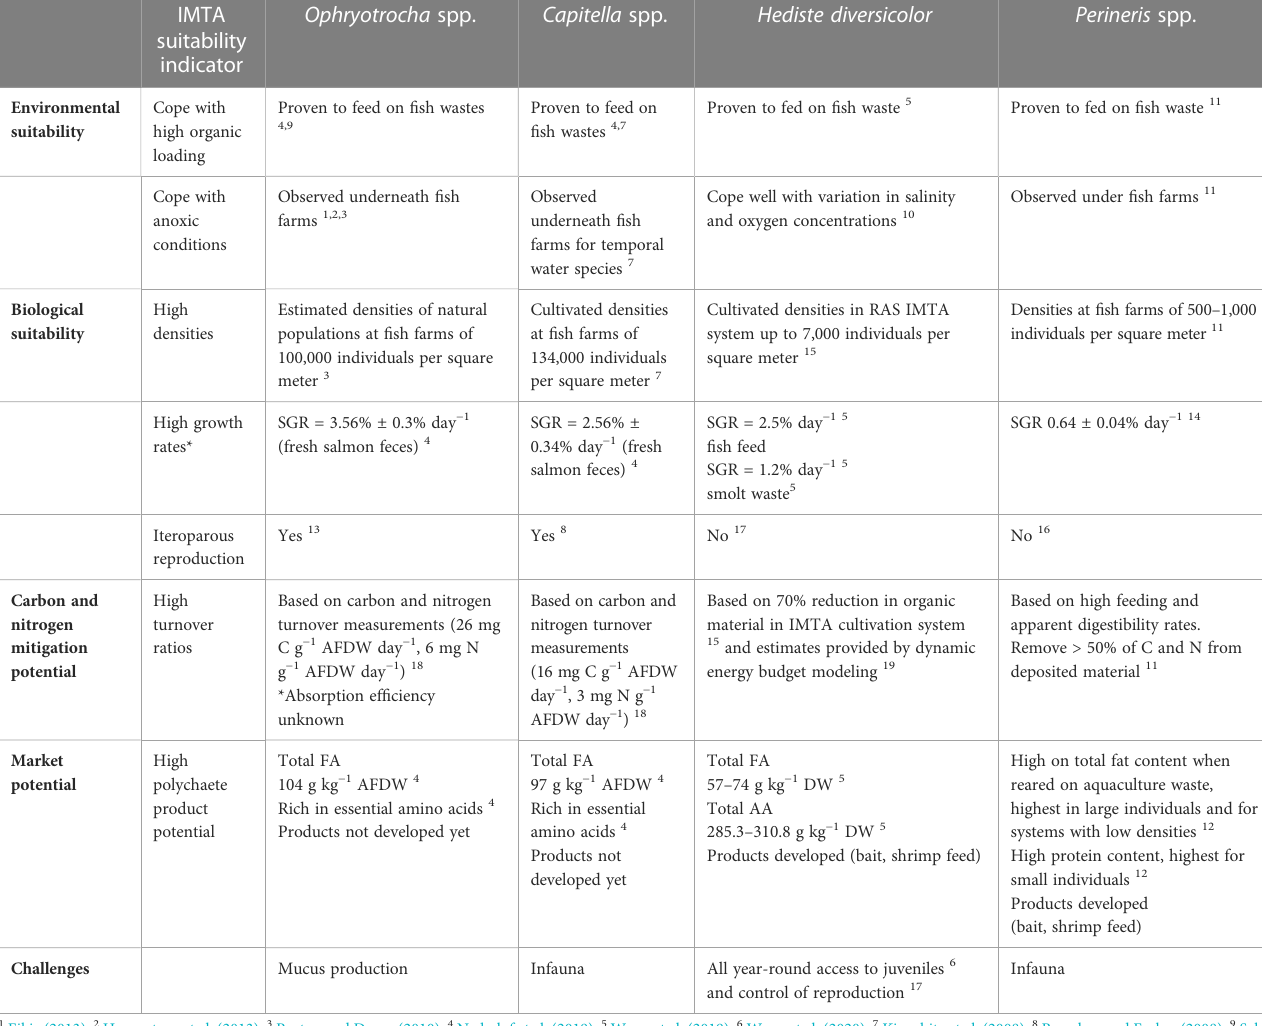
TABLE 1 Framework for evaluating the suitability of deposit feeding polychaetes as candidate species in IMTA, based on a set of IMTA suitability